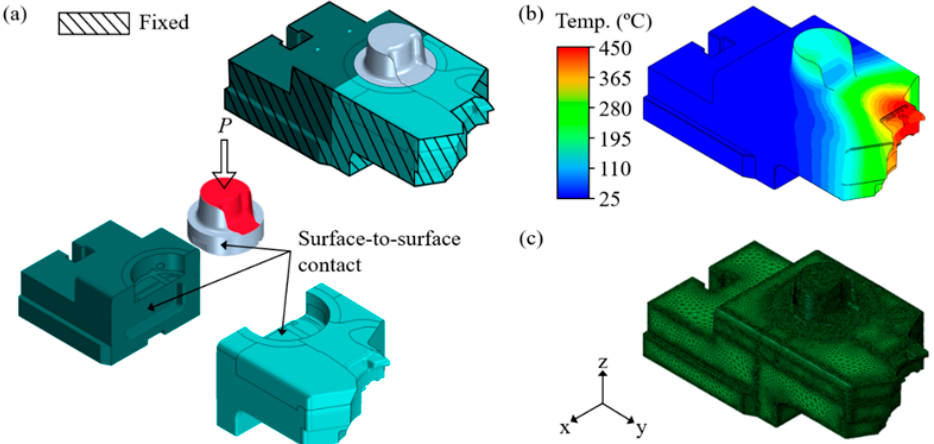
Figure 8. Boundary conditions and simulation model of thermal stress analysis. ( a ) Boundary conditions with a fixed, surface-to-surface contact, and pressure constraints. ( b ) Interpolated temperature-distribution boundary conditions. ( c ) Analysis model with generated mesh.